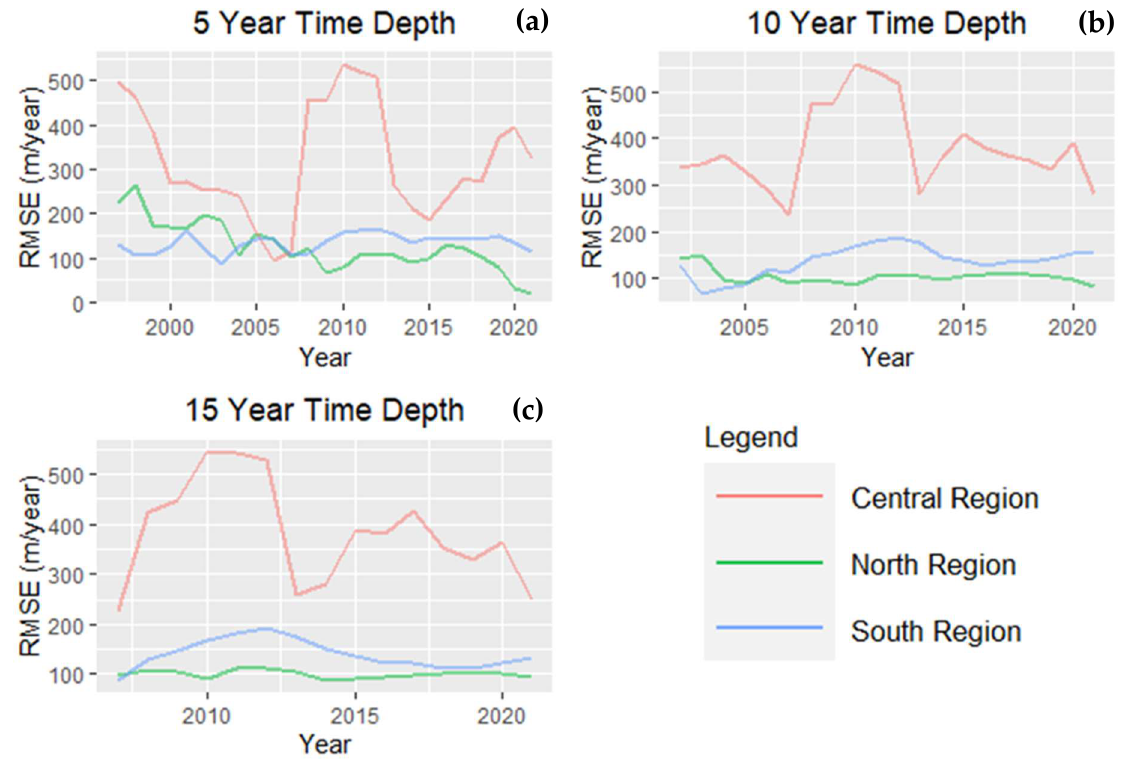
Figure 6. Variations in RMSE values calculated using the LRR rates data for predicting 5 years in the future: ( a ) 5 years’ time depth, ( b ) 10 years’ time depth, and ( c ) 15 years’ time depth.